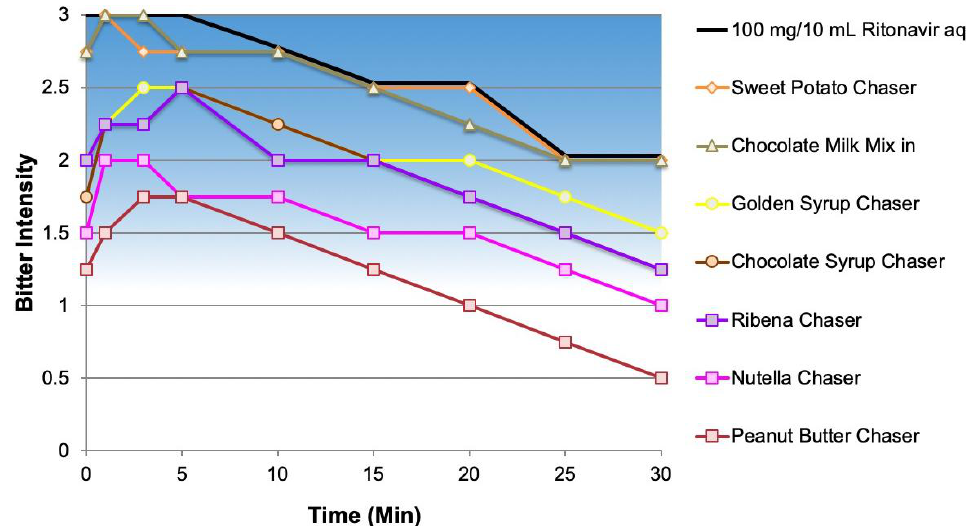
Figure 5. Bitterness profile for NOP with food chasers.